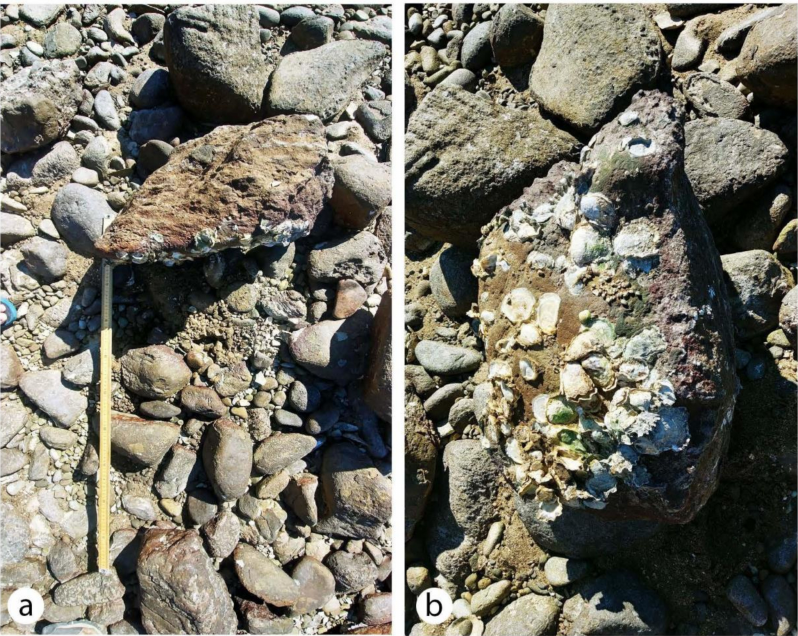
Figure 11. Contemporary oysters ( Ostrea palmula ) encrusted on a boulder near transect 7; ( a ) Boulder as first encountered on the spit (meter stick for scale); ( b ) Same boulder overturned for better view of encrusting oysters, approximately 7 cm in shell length. Note: many of the oysters remain